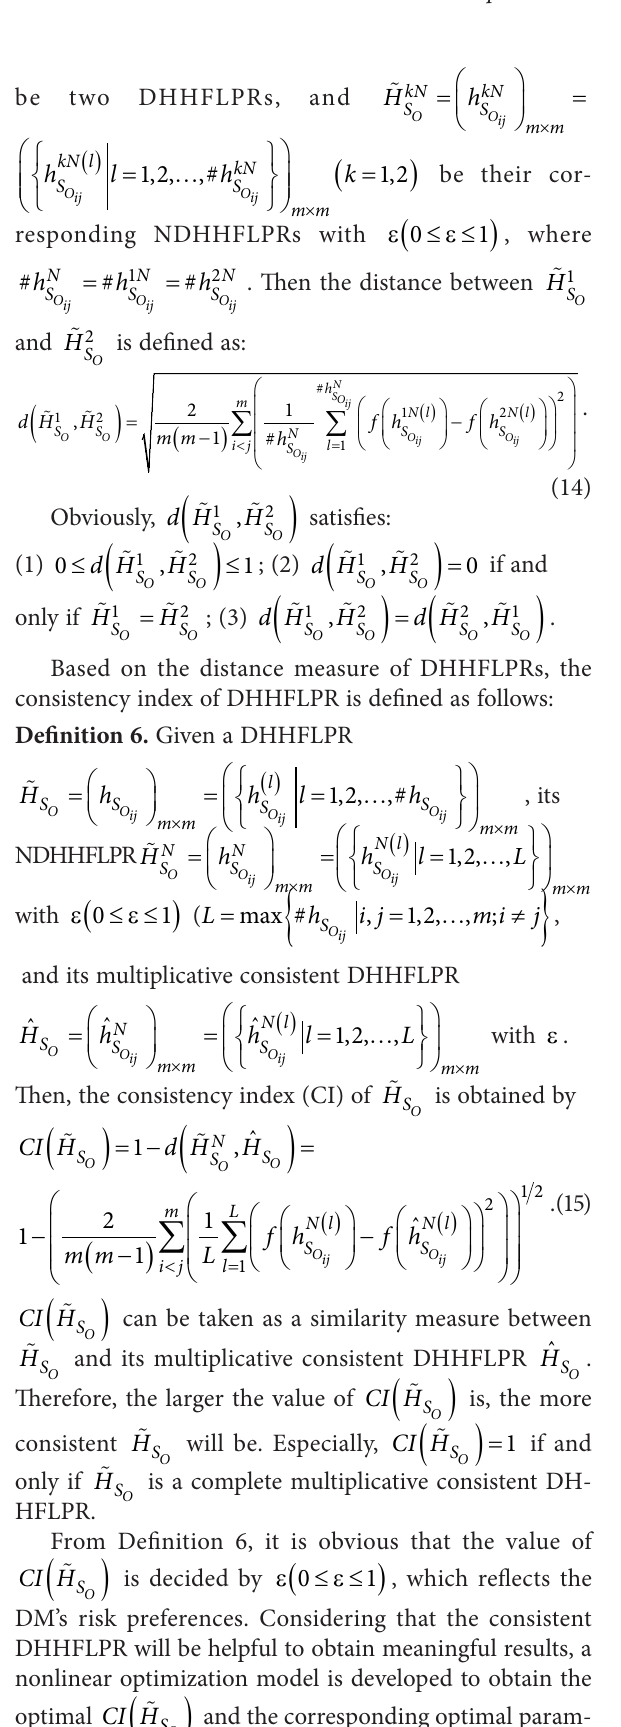
H H  and ˆ O S O S